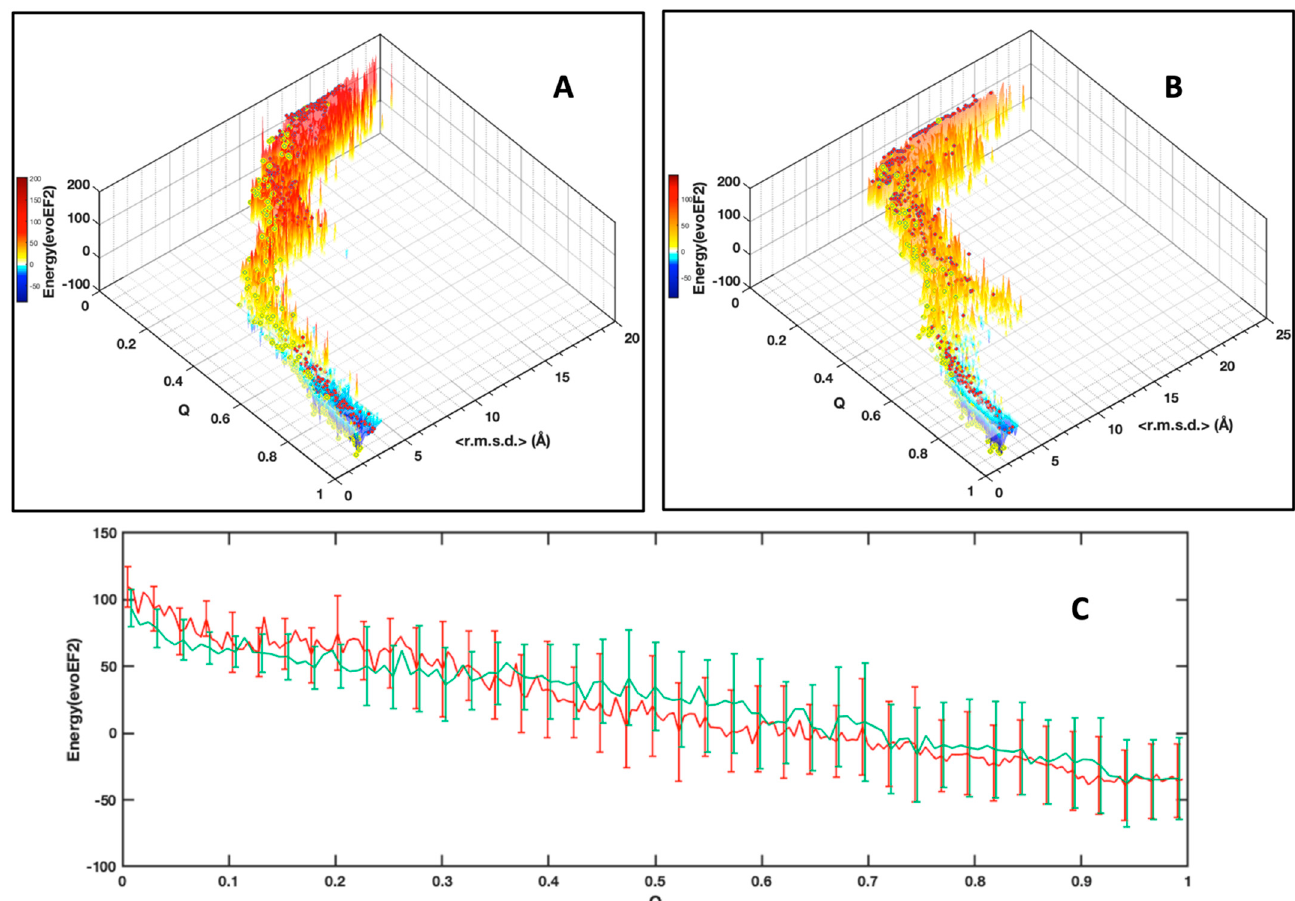
Figure 6. Distribution of the conformers free energy calculated using the evoEF2 software accord- ing to their <r.m.s.d.> (bin size 0.125 Å) and their native constraints fraction (Q) for AVR-Pia ( A ) and AVR-Pib ( B ). As in Figure 5, cluster centroids are indicated by the red dots. The centroids for the most populated (MP) clusters are indicated by the yellow dots; ( C ) Plot of the average free energy of the most populated clusters, for AVR-Pia (red) and AVR-Pib (green). The standard deviations (shown at 0.5 σ ) are indicated by vertical bars. For clarity, the standard deviation bars were regularly spaced. The gain in free energy upon folding is ΔΔ G fold = − 47 kcal/mol and − 41 kcal/mol for AVR-Pia and AVR-Pib, respectively.